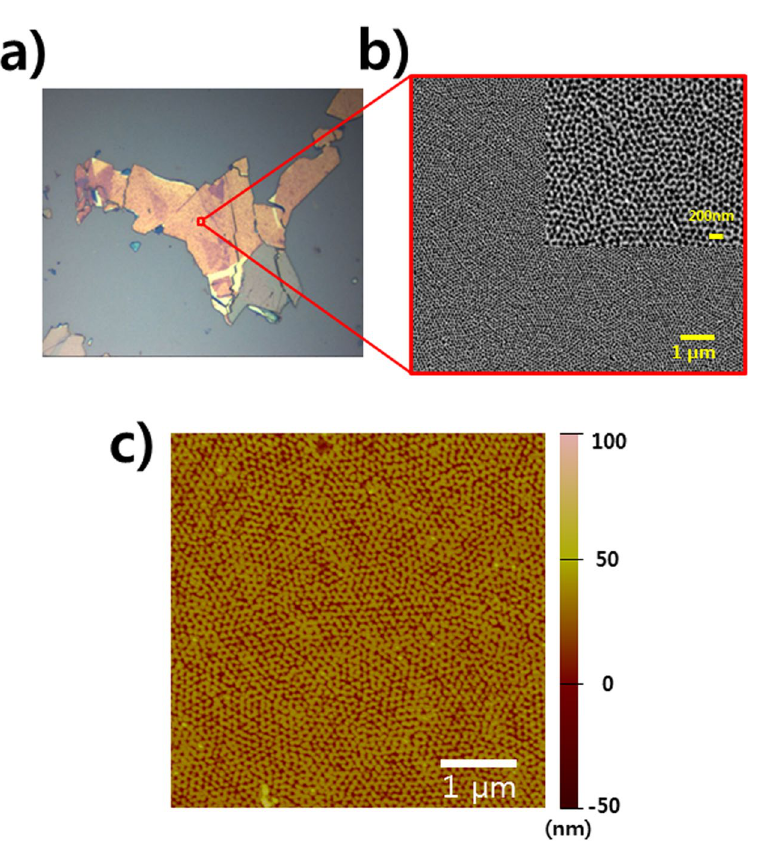
Figure 3. ( a ) Optical microscopy image and ( b ) SEM ( c ) AFM images of a large area. Inset: Magnified SEM image of nanomesh MoS 2 with a hole size of 80 nm and a neck width of 10 nm after removing Au